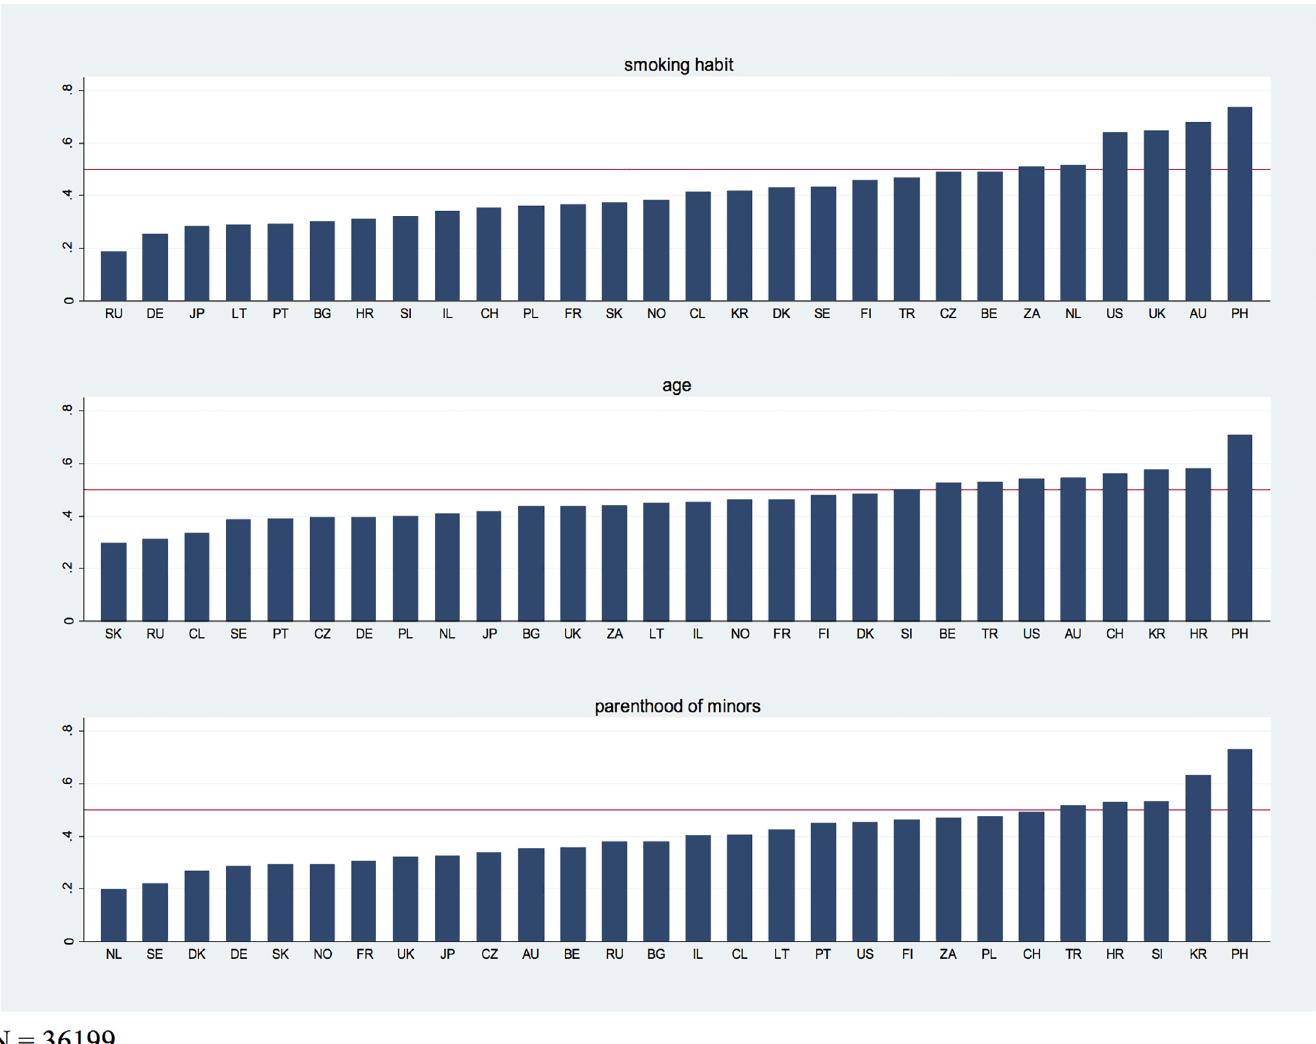
Fig 1. Proportion of support for prioritization by smoking habit, age and parental status as subordinated priority criteria by country.